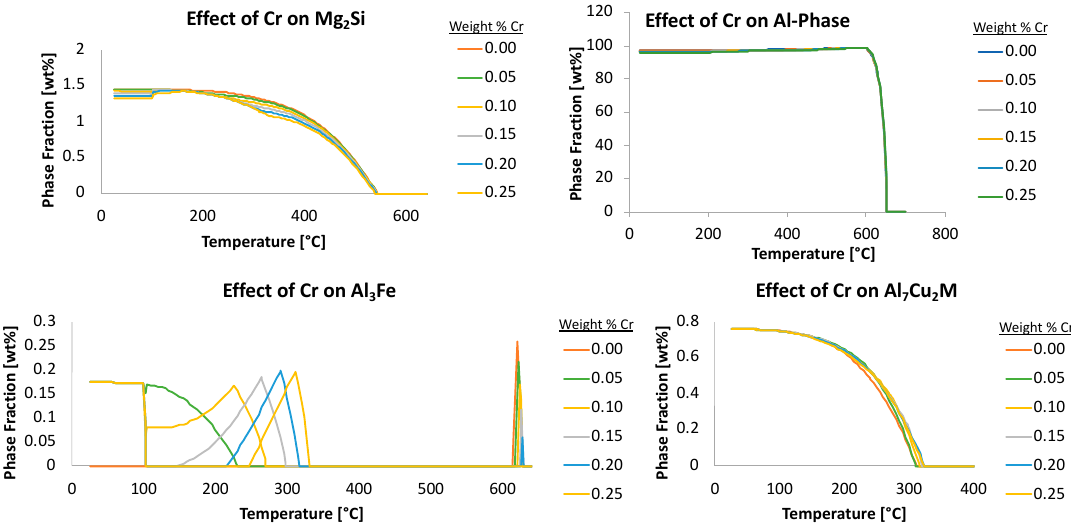
Figure 10. The effect of varied chromium content on the phase fraction of the Mg 2 Si, the aluminum matrix phase, the Al 3 Fe, and the Al 7 Cu 2 M, labeled accordingly, as a function of equilibrium temperatures. The wt.% Cr values corresponding to each curve in the respective plots was color coded in accordance with the respective legends provided.